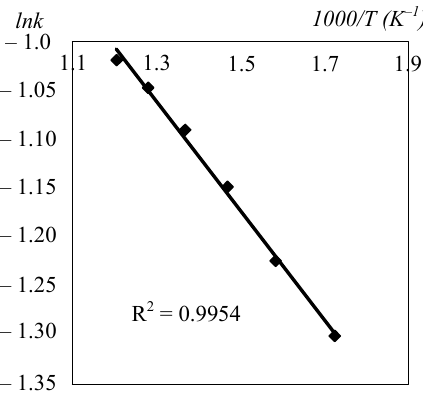
Figure 6. The effect of absolute temperature (T, K) on ln k for the “reduced” sphere equation. Temperature influence on the process rate of the fluorination of concentrate rutile, being calculated by the “reduced sphere” equation, is shown in Figure 6. For the